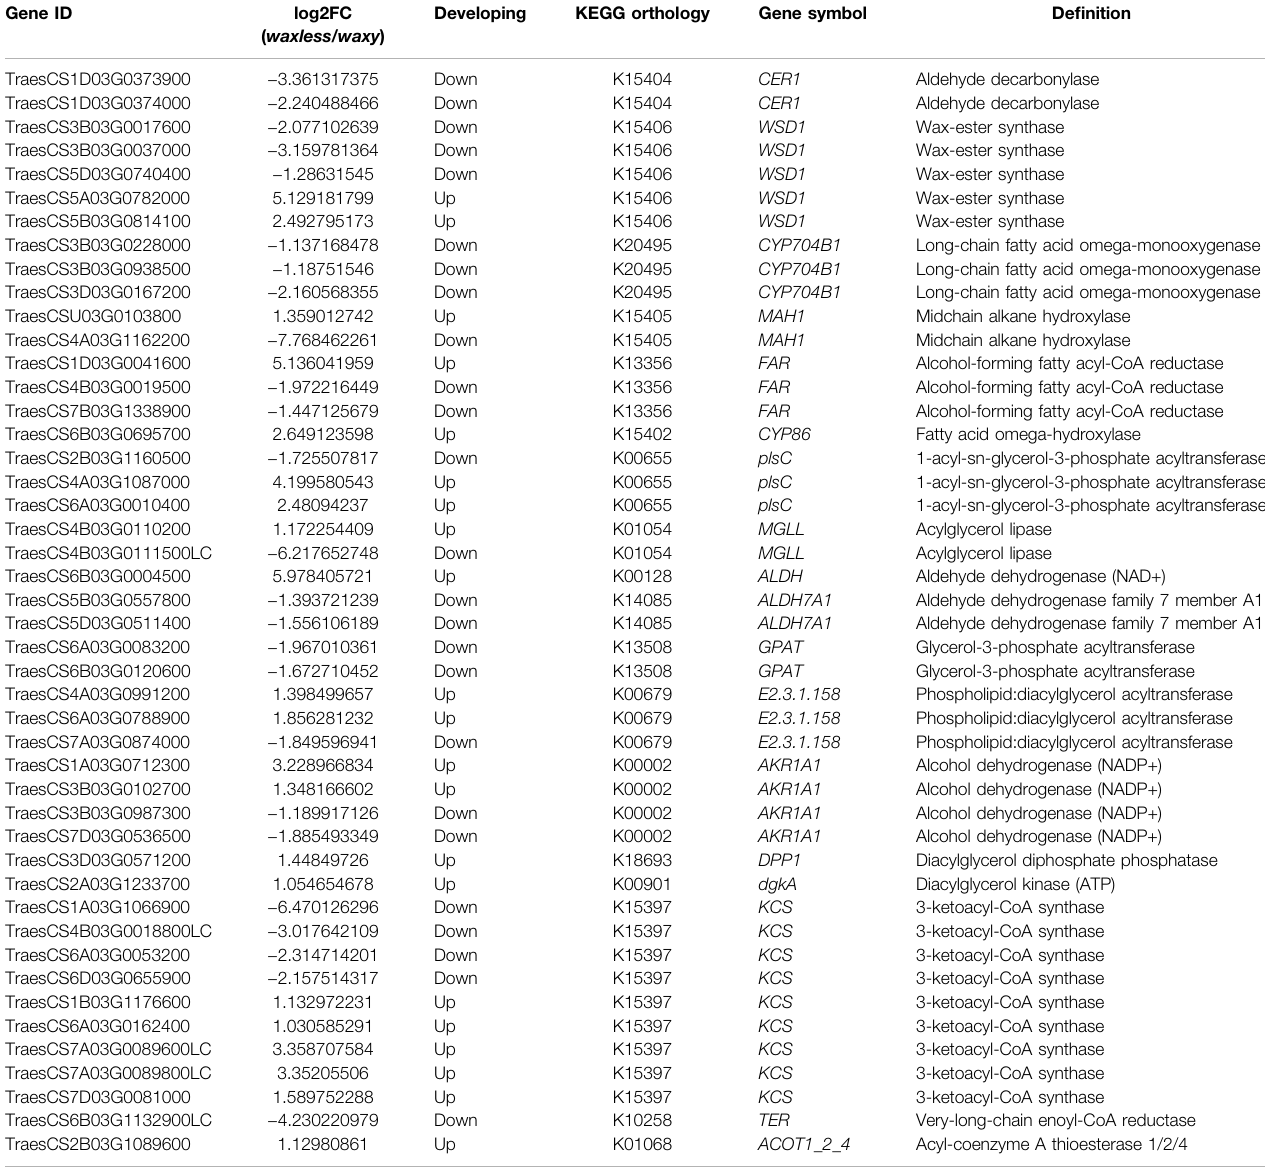
TABLE 2 | The differentially expressed genes related to epidermal wax synthesis pathway in wheat. Gene ID log2FC Developing KEGG ( waxless / waxy )